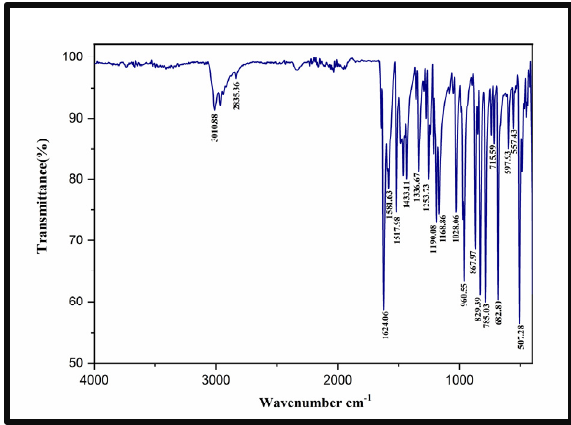
Figure 8. Fourier transform infrared spectroscopy spectrum of MMPI. Table 5. FT-IR assignments of MMPI